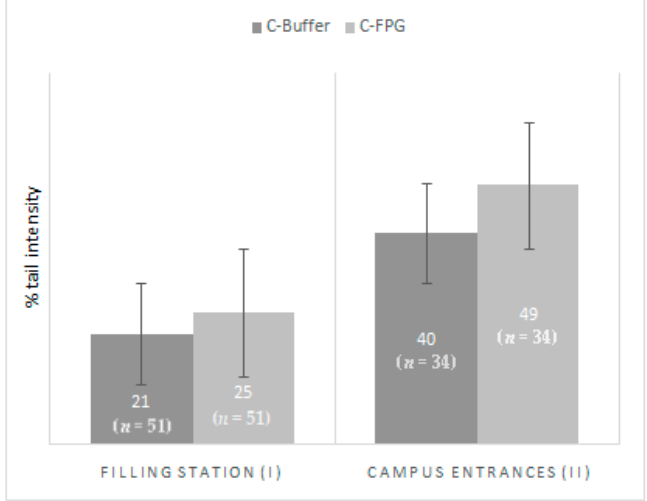
Figure4. ResultofthecometassaywithFPGforthetwogroupsofworkersexposedtobenzene. C-Bu ff er: Figure 4. Result of the comet assay with FPG for the two groups of workers exposed to benzene. mean of samples treated with bu ff er; C-FPG: mean of samples treated with bu ff er + FPG C-Buffer: mean of samples treated with buffer; C-FPG: mean of samples treated with buffer + FPG enzyme.